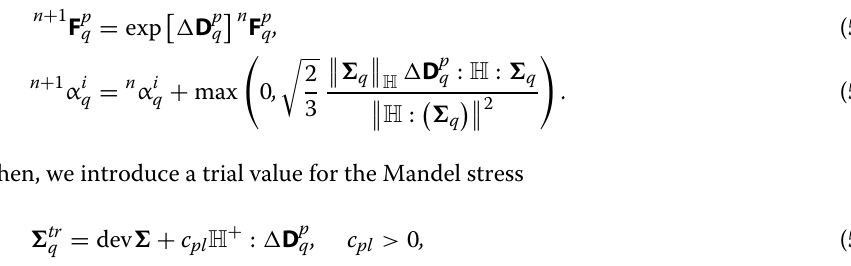
Solution algorithm using nonlinear complementarity